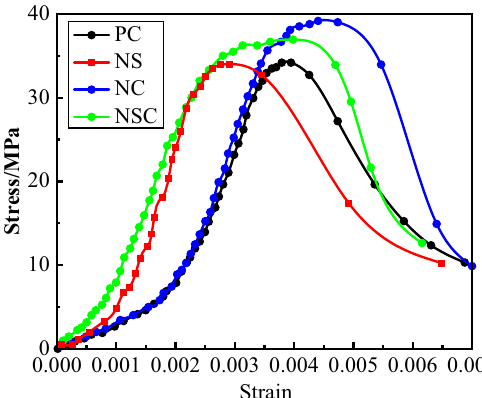
Figure 8. Stress–strain curve of concrete under static compression load.